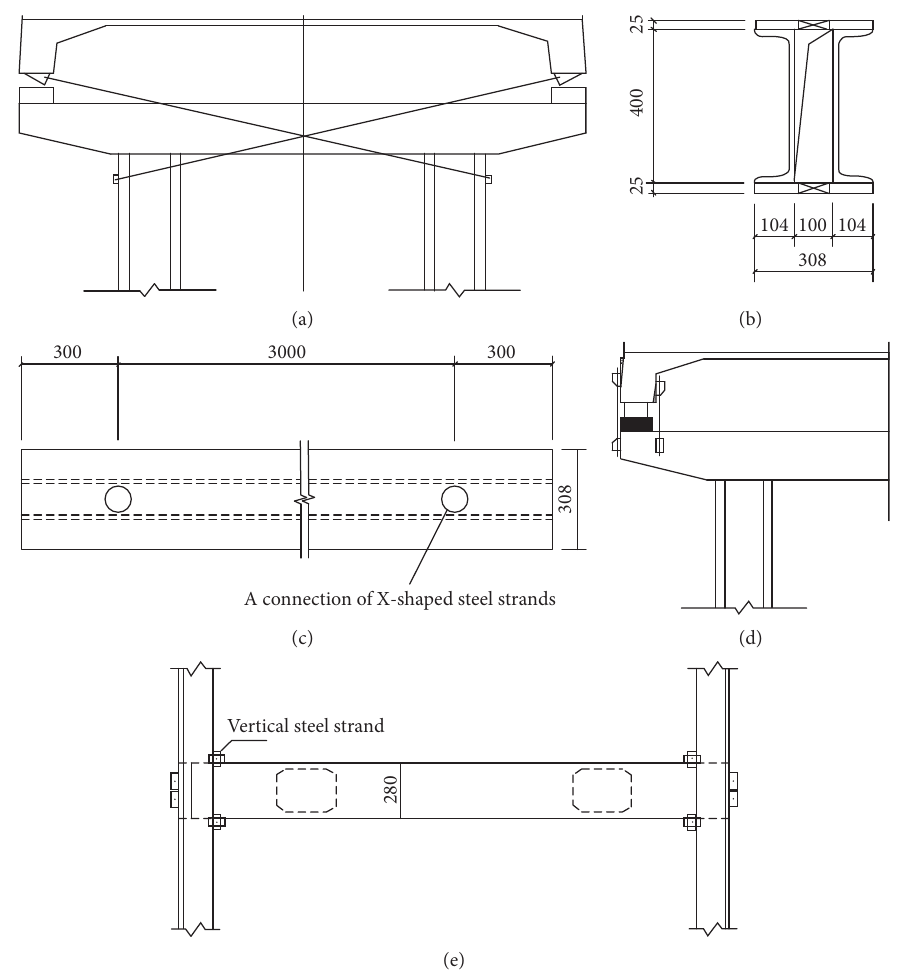
Figure 5: Sketches for repair scheme 1. (a) 1 st level repair (emergency rescue). (b) Cross section of steel channel members arranged on two sides of the bridge piers for fixing the X -shaped steel strands (unit: mm). (c) Top view of steel channel members arranged on two sides of the bridge piers for fixing the X -shaped steel strands (unit: mm). (d) 2 nd level repair (bearings repair). (e) Plan view of 2 nd level repair.